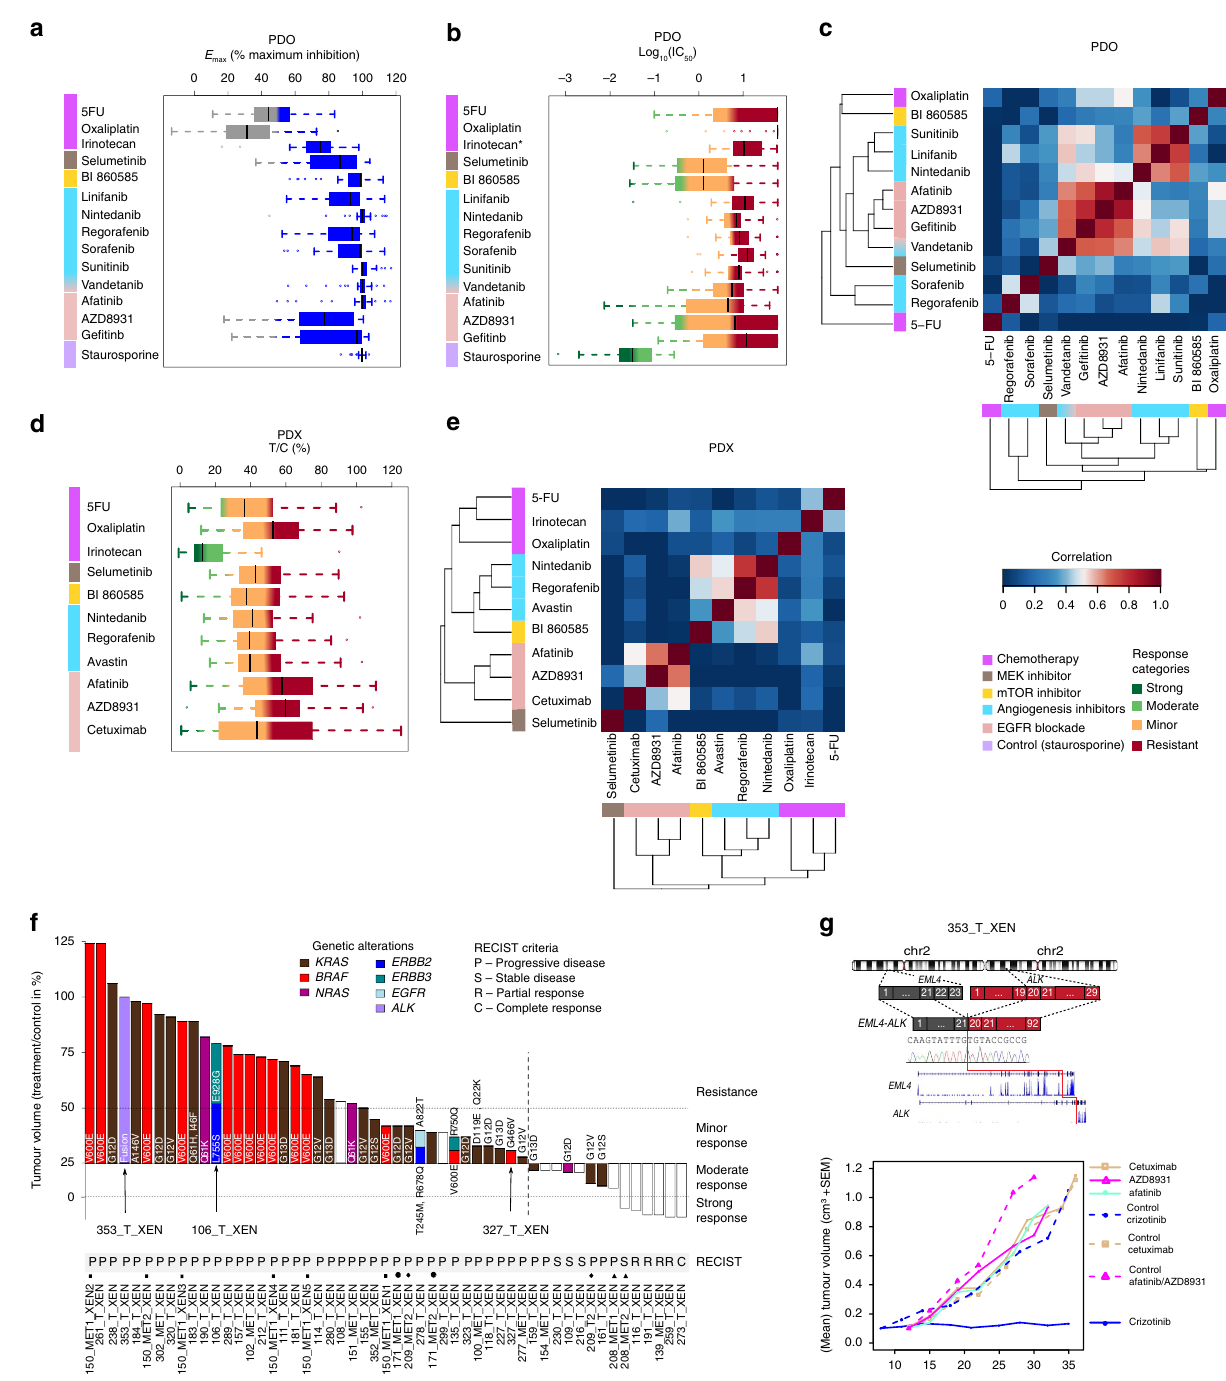
Figure 6 | Overview of drug response in PDX and PDO models. ( a ) Box plot showing the maximum inhibition ( E max ) values for 14 drugs and for the staurosporine control in 35 PDO models. Irinotecan was tested on 21 PDOs. Range of drug efficiency ( E max 4 50%) or inactivity ( E max o 50%) is indicated in blue and grey, respectively. ( b ) Box plot showing the potency of 14 drugs and of the staurosporine control based on log 10 (IC 50 ) in 35 PDO models. The four response categories are coloured as indicated in the caption. ( c ) Hierarchical clustering representing the correlation of drug sensitivity patterns in PDOs based on the log 10 (IC 50 ) values. ( d ) Box plot showing the sensitivity of 57 PDX models to 11 drugs based on tumour/control volumes (T/C in %) values: response categories are coloured as indicated in the caption. ( e ) Hierarchical clustering representing the correlation of drug sensitivity patterns based on T/C values in PDXs. ( f ) Waterfall plot showing cetuximab sensitivity for 53 PDX and indicating mutations and fusions in RAS/RAF and RTK pathways. Both T/C and RECIST results are indicated; models derived from the same patient are labelled with the same symbol above each sample name. The vertical dash line shows the cut- off between responders and non-responders. ( g ) Analysis of the activating ALK gene fusion in 353_T_XEN; upper part: schematics displaying chromosomal location, fusion partners, exon structure (grey and red boxes), fusion breakpoint (red line), validation by Sanger sequencing and RNA read coverage. Lower part: treatment response of OT PDX 353_T_XEN to crizotinib, cetuximab, AZD8931 and afatinib: mean tumour volume of treated and corresponding controls measured between day 8 and day 36 after